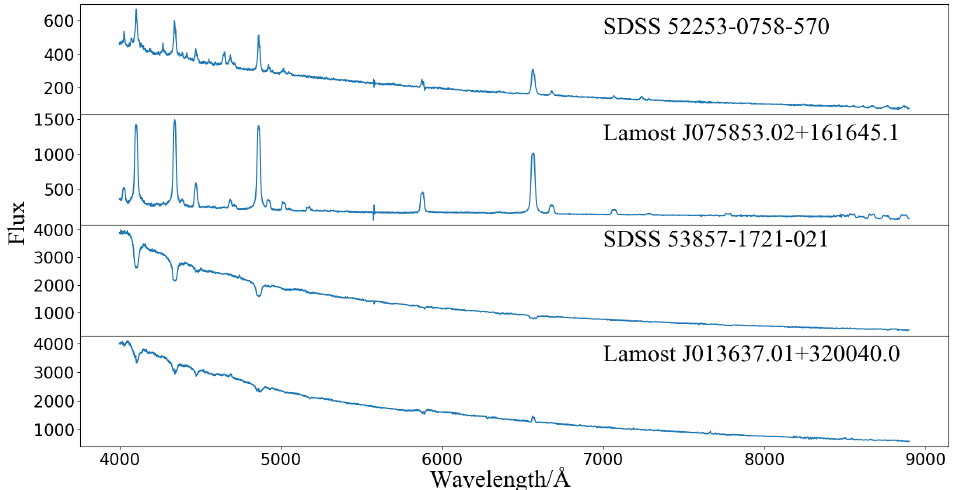
Figure 1. Two types of CV spectra. The upper two CV spectra are in the quiescent period, which show emissions of Balmer and He lines. The lower two are in the outburst period, which show the absorption of Balmer